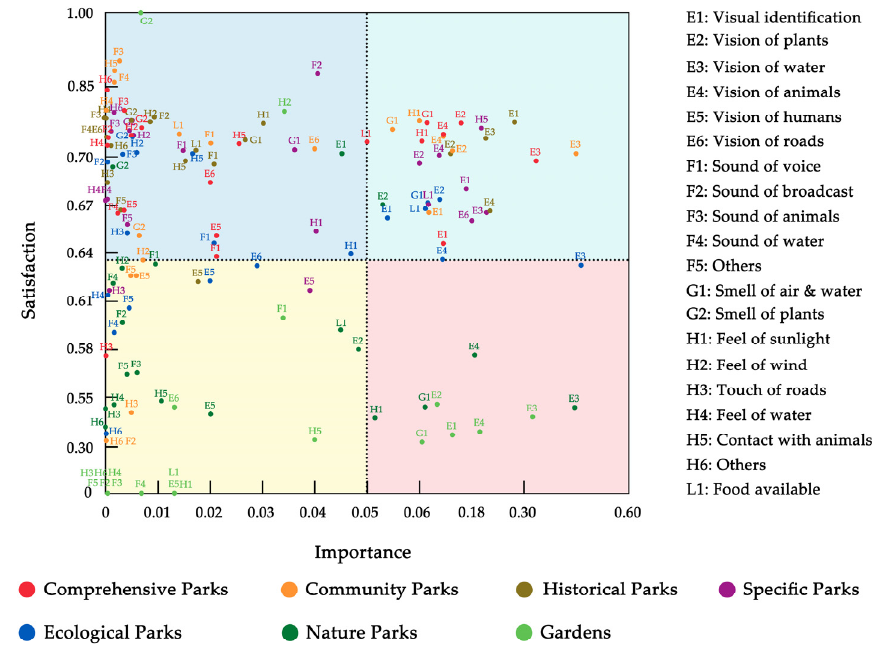
Figure 10. IPA model of riverside parks of different types based on visitors’ sensory perception.